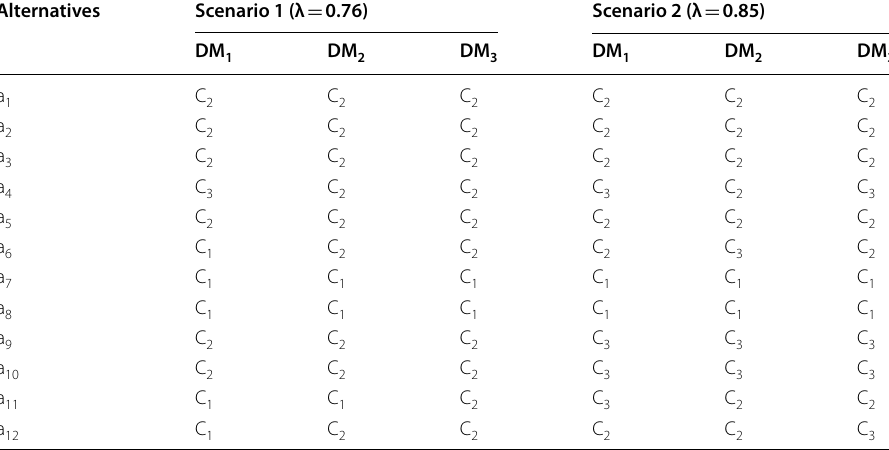
Table 7 Results of the